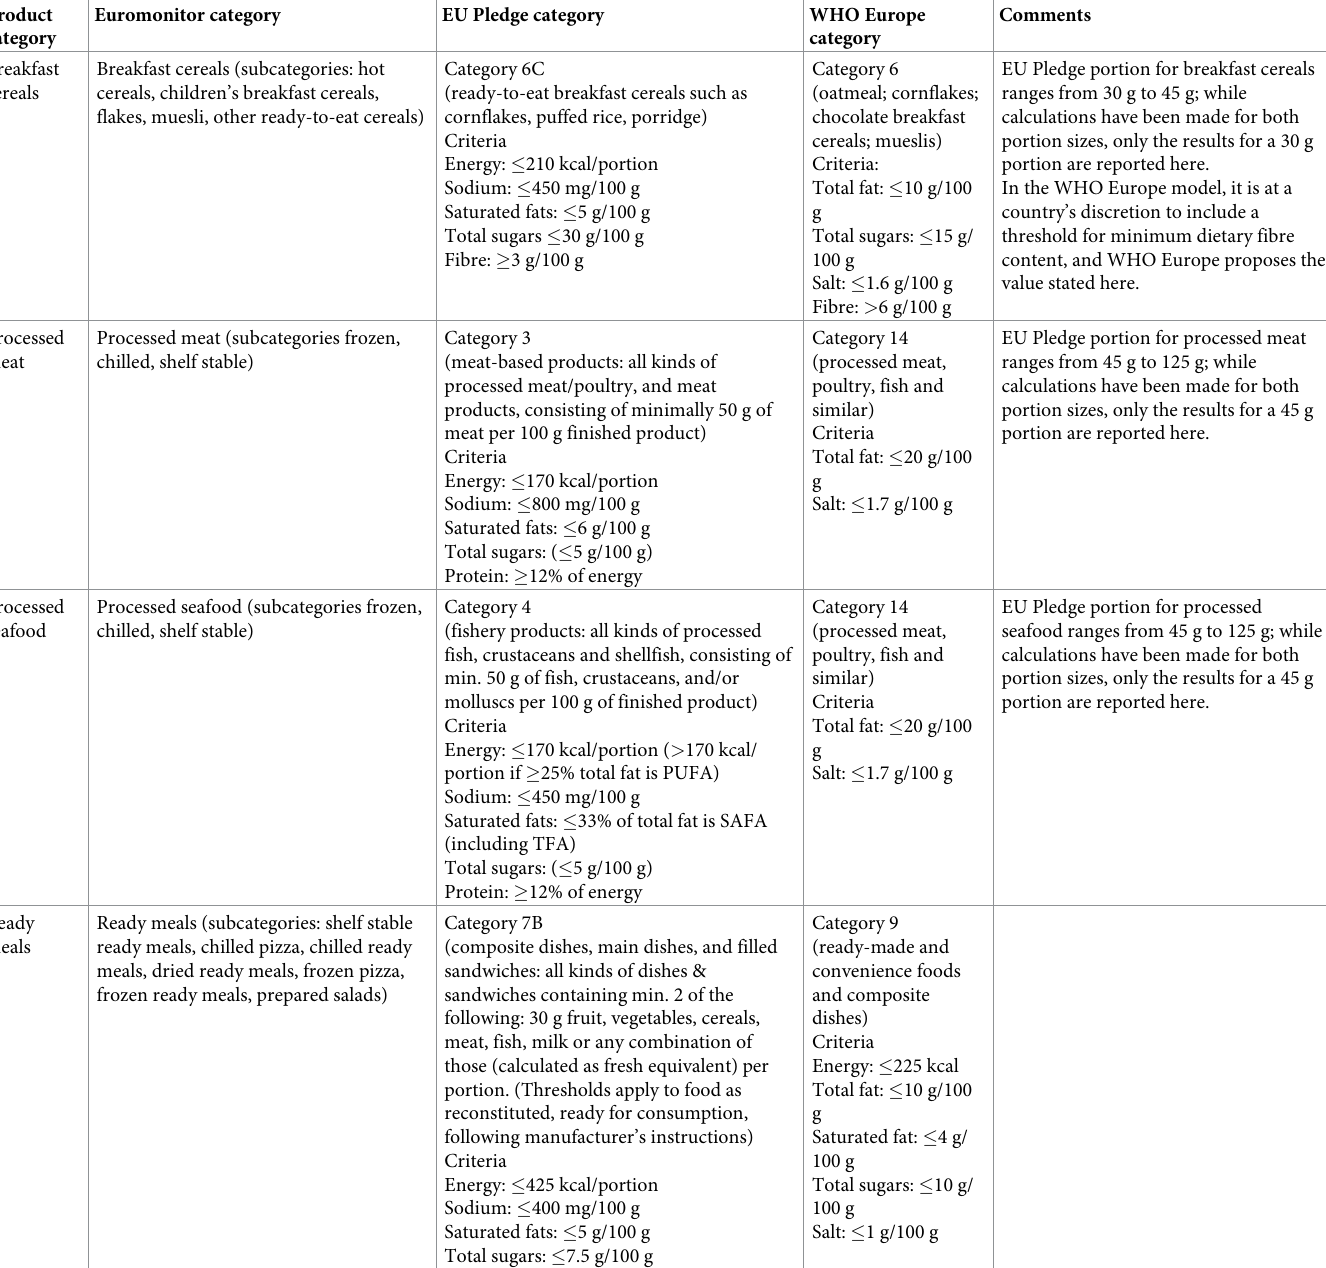
Table 1. Product categories selected for inclusion in the nutrient profile comparison, their corresponding categories in the Euromonitor database, and the nutrient profile categories in the EU Pledge and WHO Europe models. Product